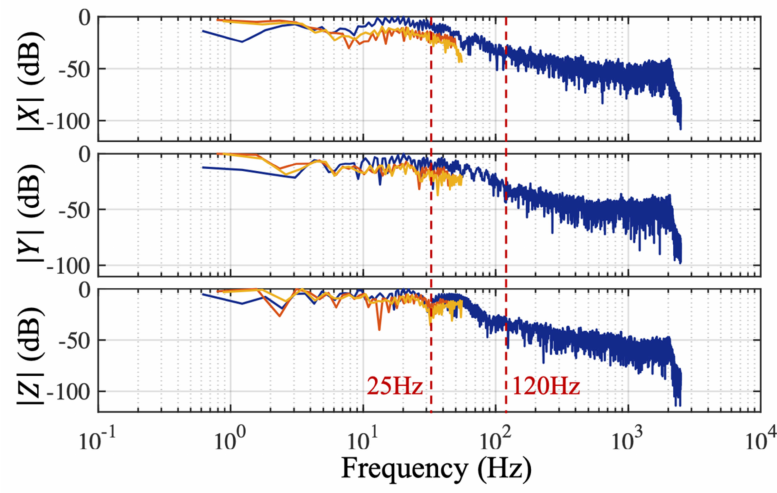
Figure 9. Spectrum of acceleration signals from one normalized stride sampled at 5000 Hz (blue: DJB), 100 Hz (red: Nushu), and 100 Hz (yellow: Axivity).